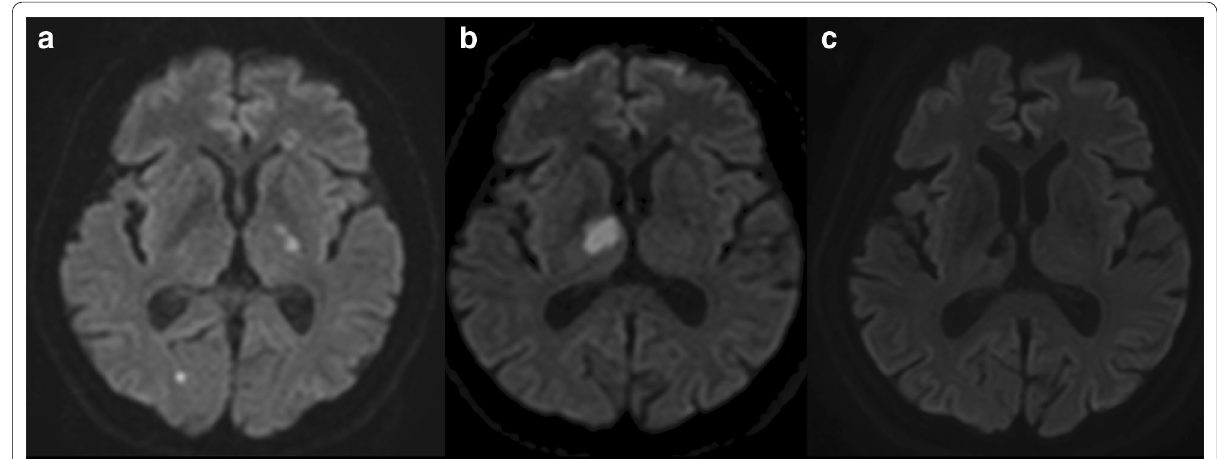
Fig. 1 Brain diffusion-weighted magnetic resonance images. a multiple cerebral infarctions (right occipital lobe, left internal capsule putamen). b Cerebral infarction recurrence (internal capsule of the right thalamus) seen 1 month later. c No cerebral infarction 6 months postoperatively